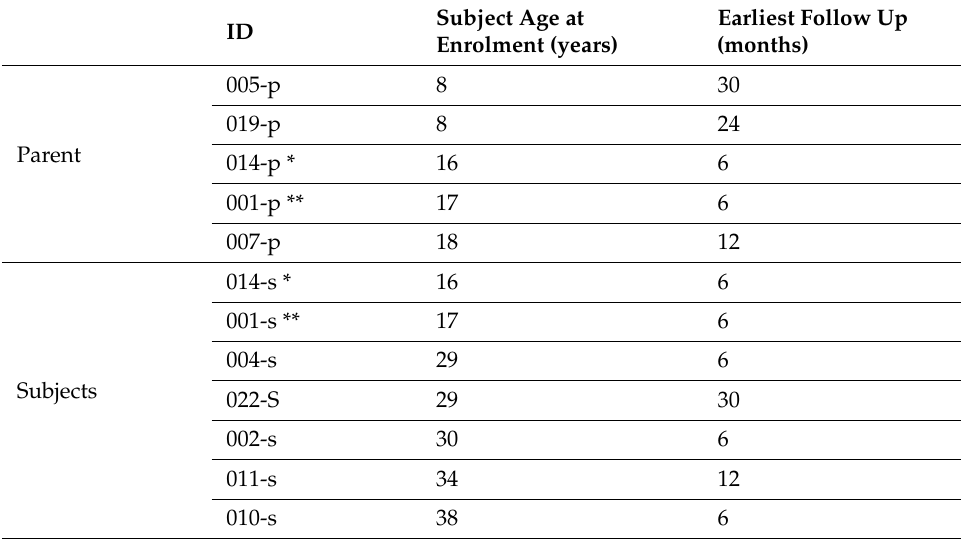
Table 2. Participant Enrollment Age and Follow-up